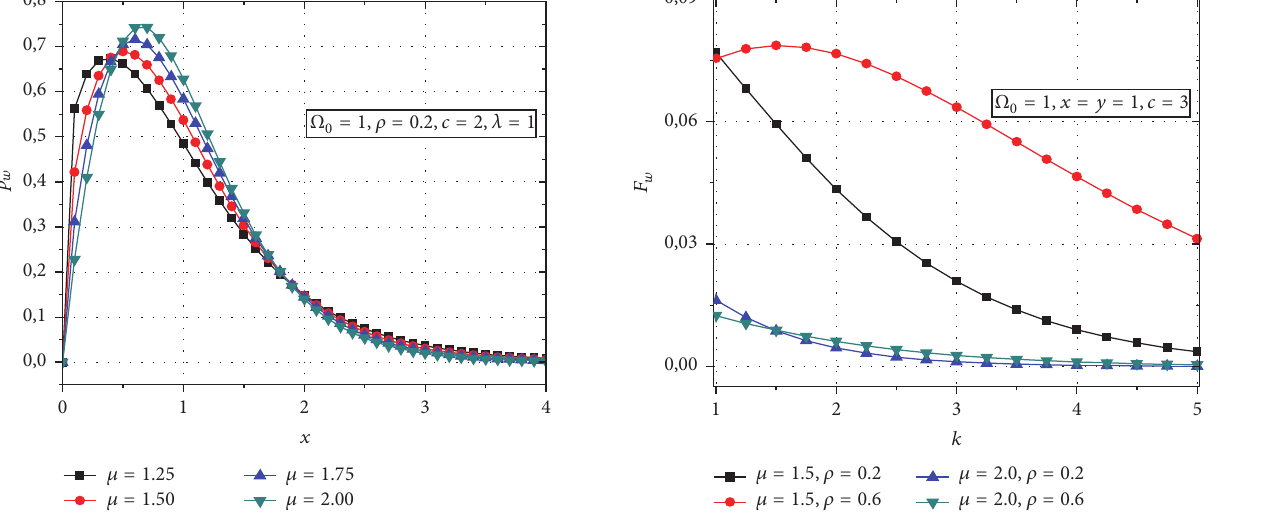
Figure 4: Cumulative distribution function of macrodiversity SC receiver output signal envelope versus Rician factor k